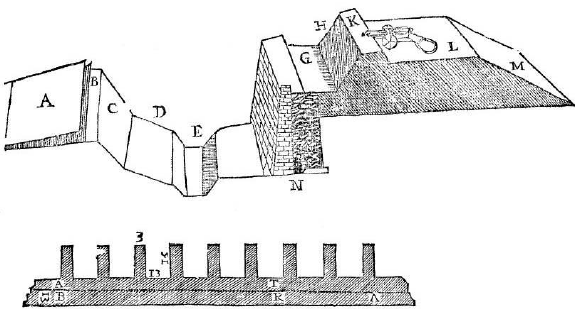
Figura 13. Imagen del “Capítulo XV. Para faber el grueffo q